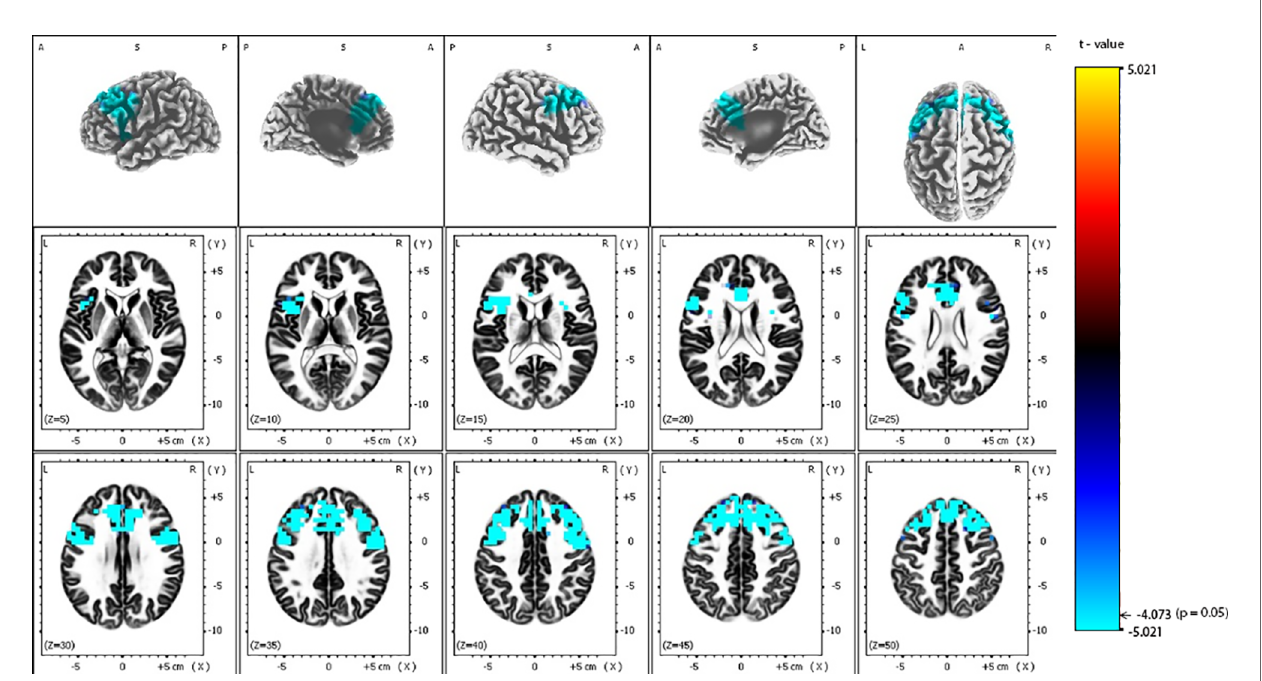
FIGURE 2 | Comparison of baseline exact low-resolution brain electromagnetic tomography (eLORETA) current density for alpha-2 frequency band (10.5 – 12 Hz) between responders and non-responders to repetitive transcranial magnetic stimulation (rTMS) treatment. Surface-rendered (upper row) and axial sliced (middle and lower row) images depicting statistical nonparametric maps (SnPMs) are based on voxel-by-voxel independent t-tests of the eLORETA images based on the log- transformed power of the estimated electric current density. A signi fi cant decrease (p < 0.05) in the baseline alpha-2 eLORETA current density for rTMS responders is shown in the bilateral frontal lobes, insula and anterior cingulate. Structural anatomy is shown in grayscale (A, anterior; P, posterior; S, superior; L, left; R, right); x, y, z = Talairach coordinates. The threshold value (t = -4.073) for statistical signi fi cance (corresponding to p=0.05) is reported at the color scale on the right side of the fi gure.